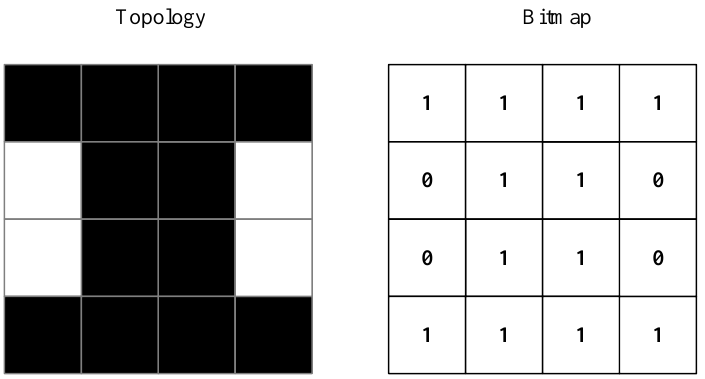
Figure 2. An example of topology bitmap representation (1 – filled, 0 – void).